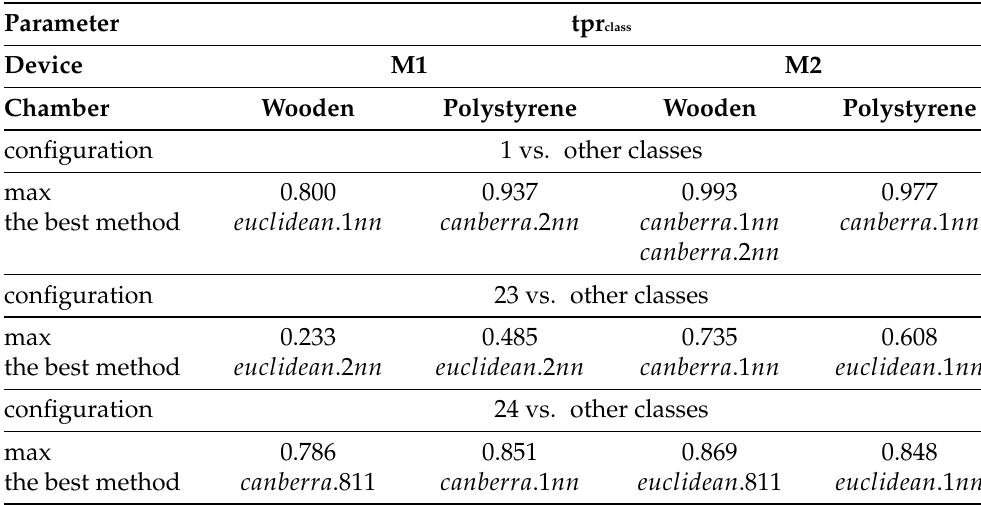
Table 5. Summary of the highest values of tpr class obtained in the 5 × MCCV-5 validation tests: specific class vs. other classes including classifiers that enabled obtaining the result (the best method) for devices M1 and M2.